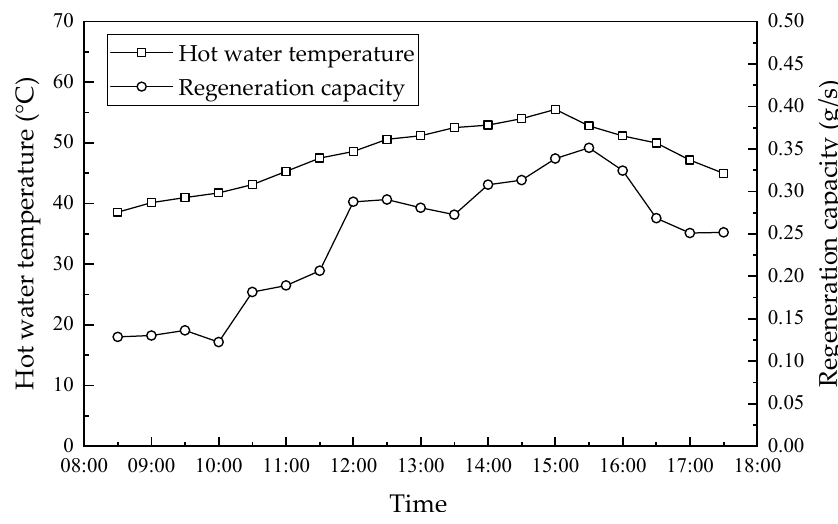
Figure 13. Hourly variation in hot water temperature and regeneration capacity.